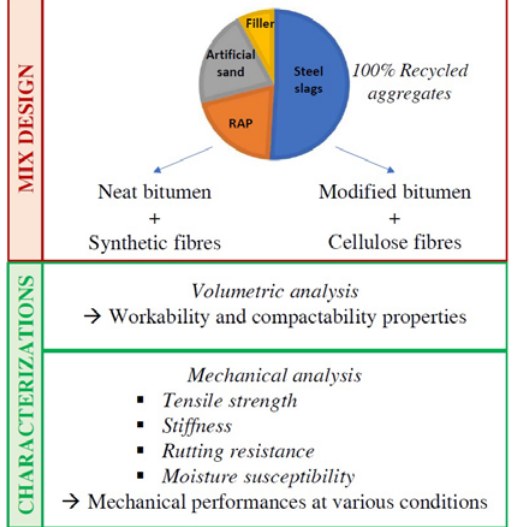
Figure 1. Summary of the experimental programme.